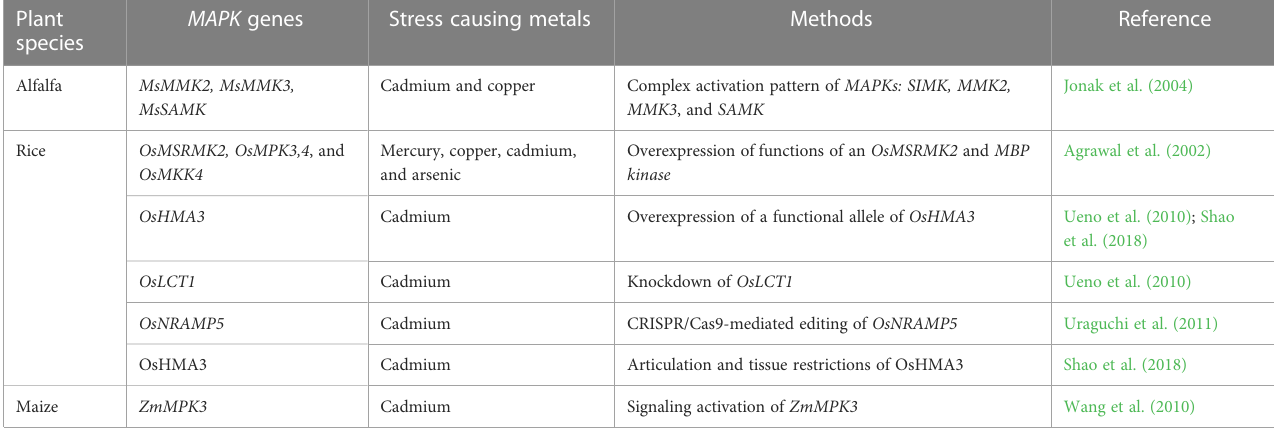
TABLE 5 MAPK gene signaling responses in different plants under heavy metal stress conditions. Plant